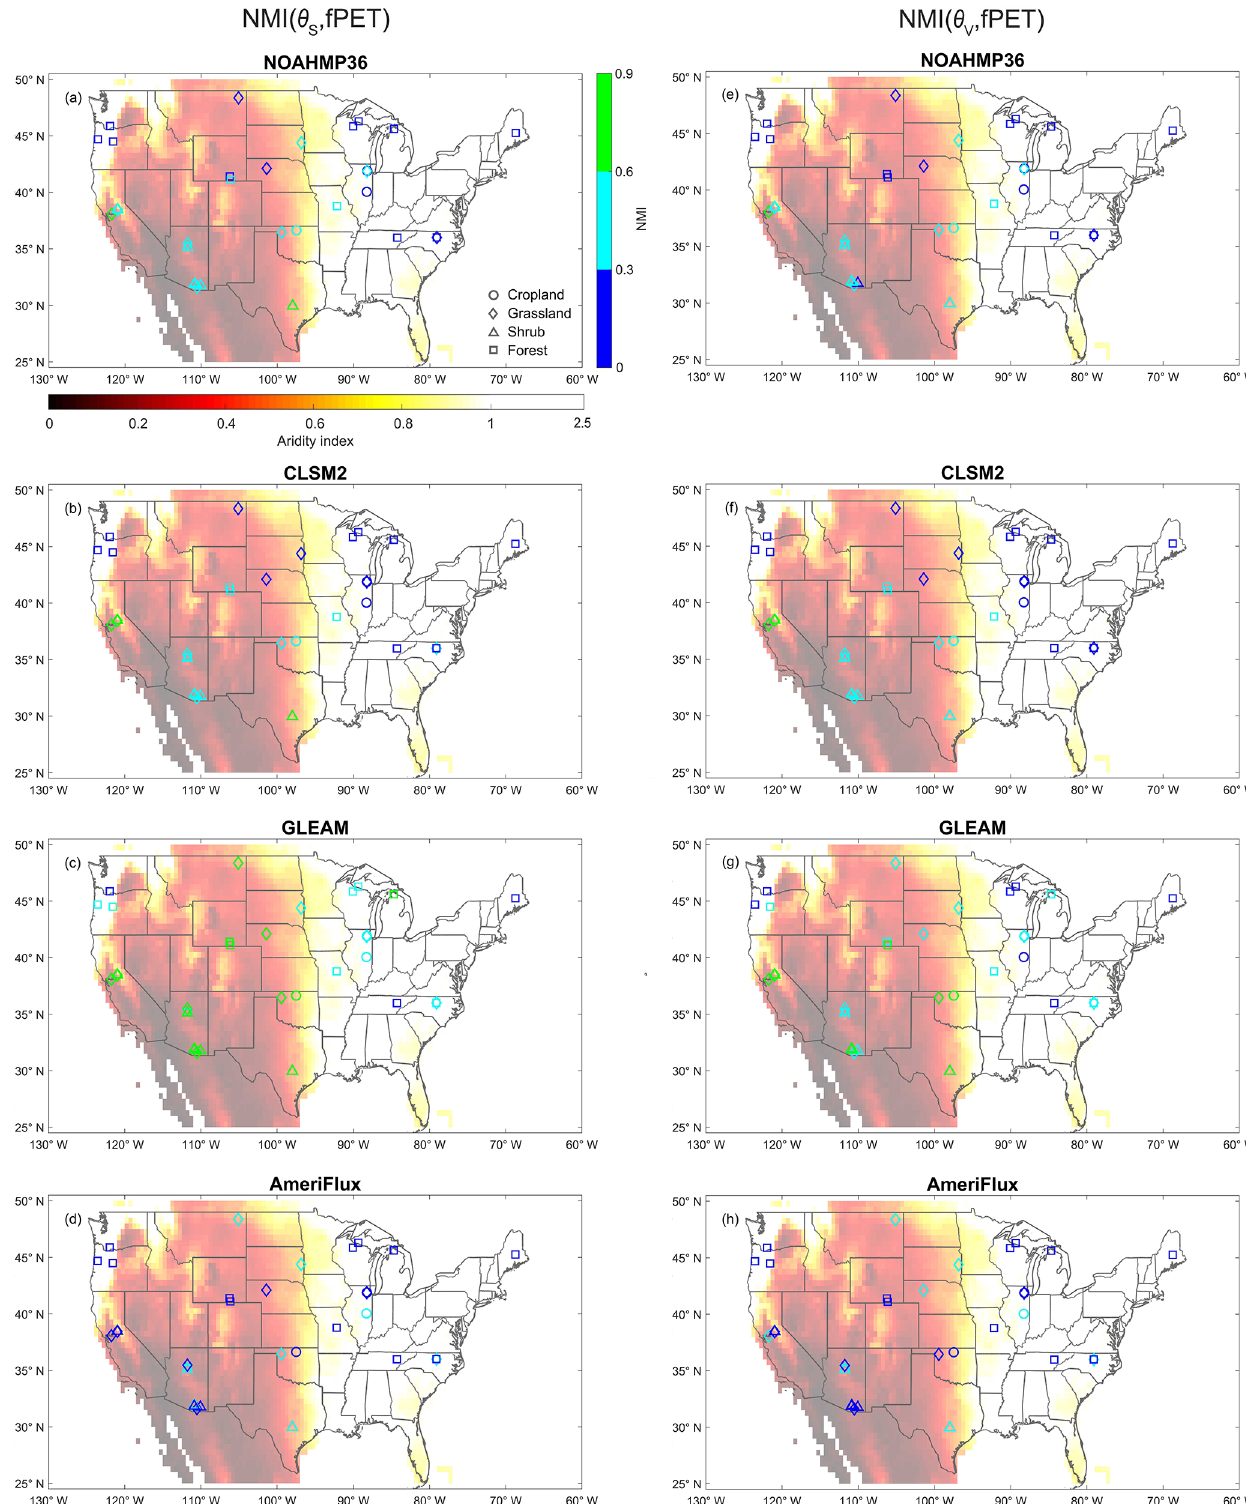
Figure 3. NMI( θ s , fPET) (left panels) and NMI( θ v , fPET) (right panels) estimates at AmeriFlux sites for (a, e) NOAHMP, (b, f) CLSM, (c, g) GLEAM and (d, h) AmeriFlux. Marker color reflects NMI magnitudes and symbol type reflects local land-cover type at each site. Background color shading reflects aridity index (AI)